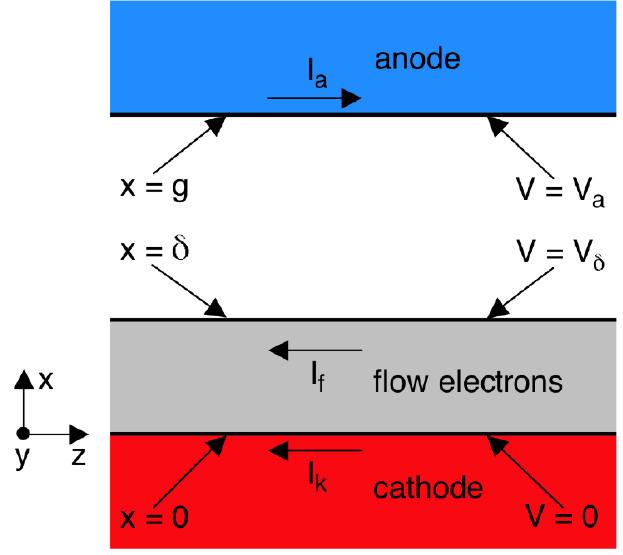
FIG. 1. (Color) Idealized 1D magnetically insulated transmis- sion line (MITL) in planar geometry [16]. This figure assumes that the electromagnetic power flows in the positive- z direction. The electric- and magnetic-field vectors point in the negative- x and negative- y directions, respectively. The quantity g is the is anode-cathode gap, (cid:10) is the thickness of the electron sheath, I a is the electron-flow the magnitude of the bound anode current, I f current, I is the bound cathode current, V is the total MITL k a is the voltage at the edge of the voltage, and V (cid:10)